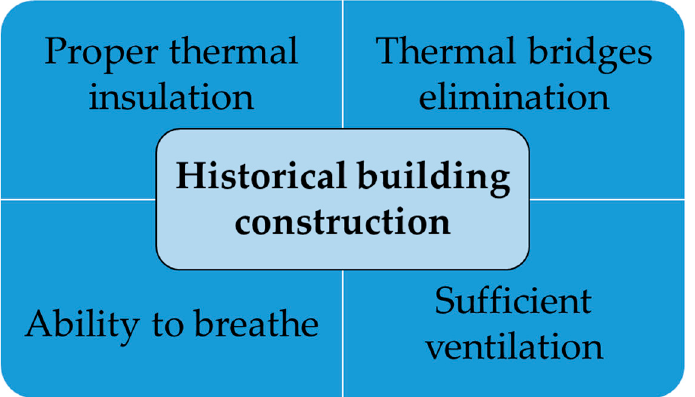
Figure 1. The problems of historical building construction associated with occupancy.